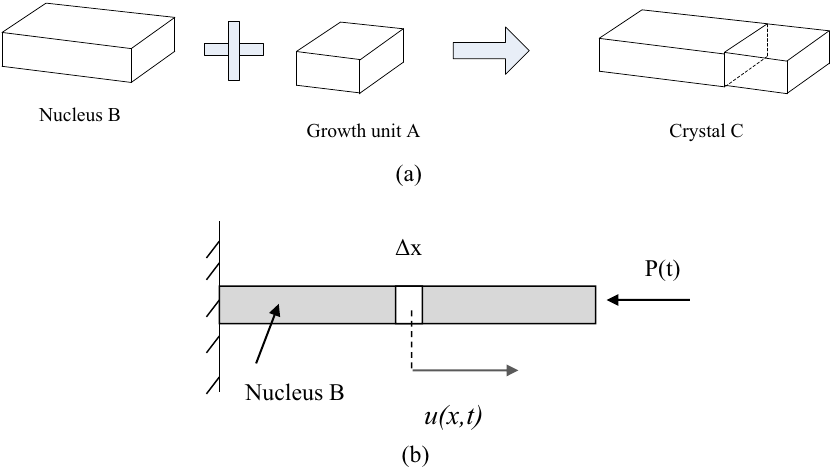
Figure 4: ( a ) Three - dimensional schematic diagram of crystal C is obtained by combining growth unit A and nucleus B; ( b ) schematic view of elastic nucleus B undergoing axial